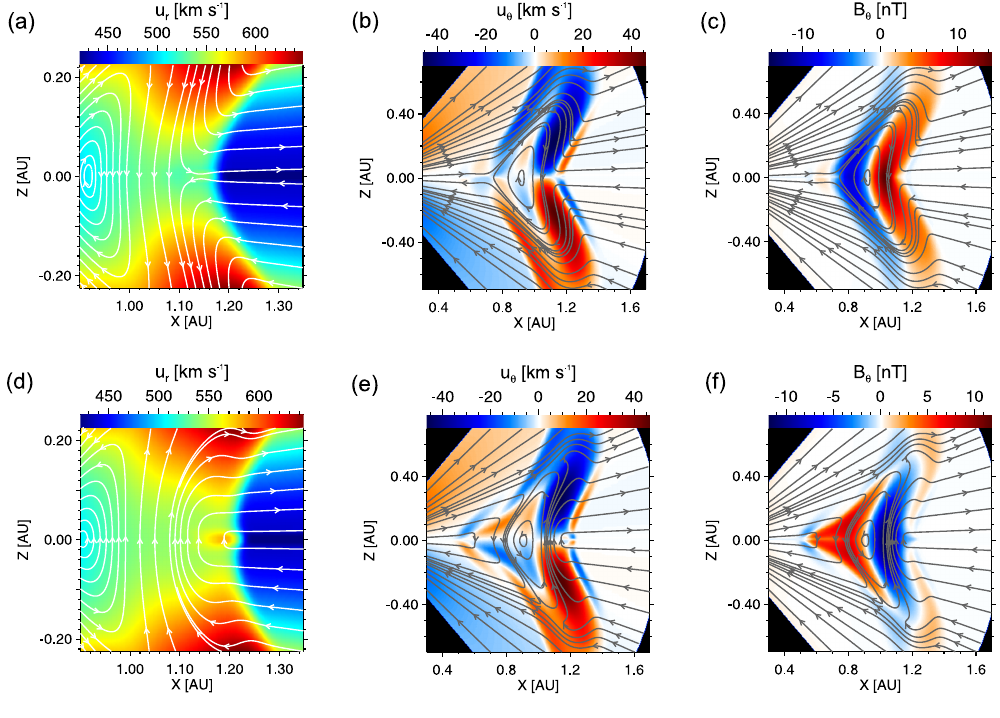
Fig. 16. Grids for the spherical velocity components u r and u θ of H − m (a, b) and H + m (d, e) . Grids (a) and (d) are zooming into the equatorial shock front. The polar magnetic field B θ is displayed in (c) for H − m and in (f) for H + m . Magnetic field lines are over-plotted on each